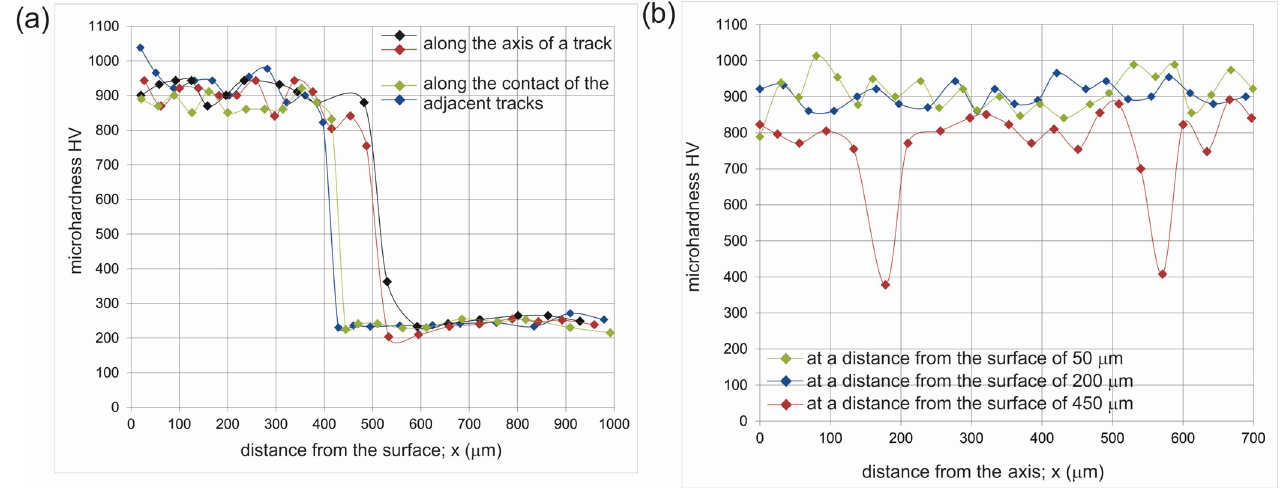
Figure 13. The microhardness profiles of laser borided layer produced on Nimonic 80A alloy at the laser beam power of 1.56 kW: ( a ) measurements along the axis of a track and along the contact of the adjacent tracks; ( b ) measurements along the straight line parallel to the surface.